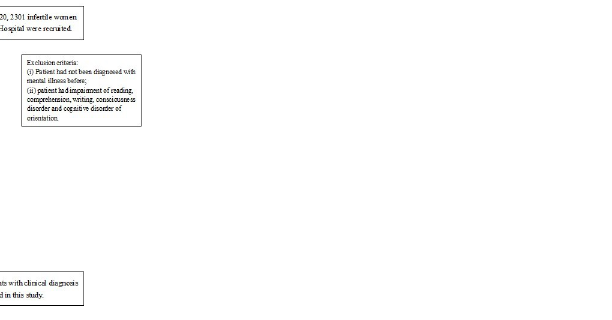
Fig 1. The flow diagram of this study. Abbreviation: GAD-7: Generalized Anxiety Disorder 7; PHQ-15: Patient health questionnaire-15; PSQI: Pittsburgh sleep quality index; PHQ-9: Patient Health Questionaire-9.